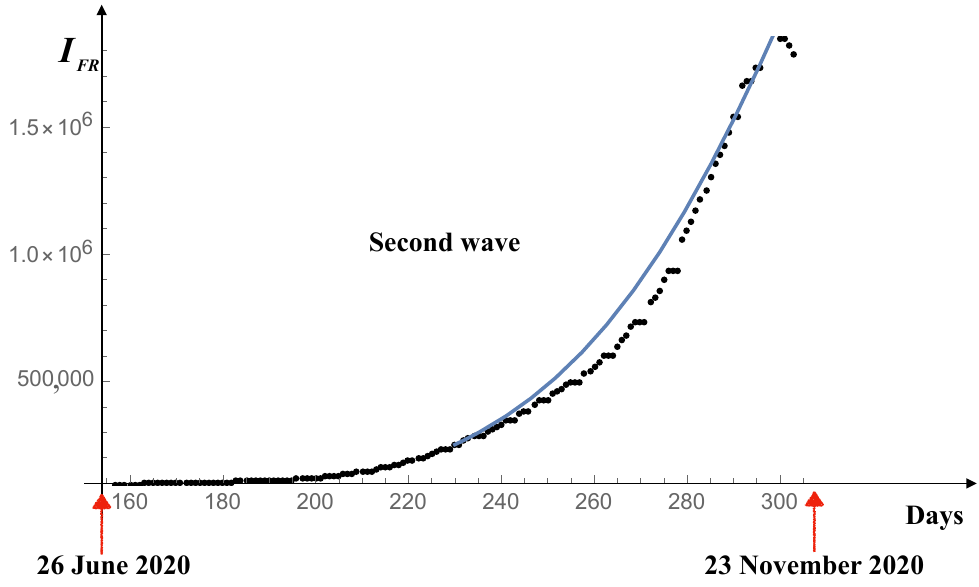
Figure 25. Comparison between the theoretical predictions (blue line) and real data (black dots) for France during the second wave of Coronavirus. The values of the parameters are; ˜ α = 0.035 day − 1 , β = 0.5 day − 2 , K = 5,000,000, and t L = 278 days,